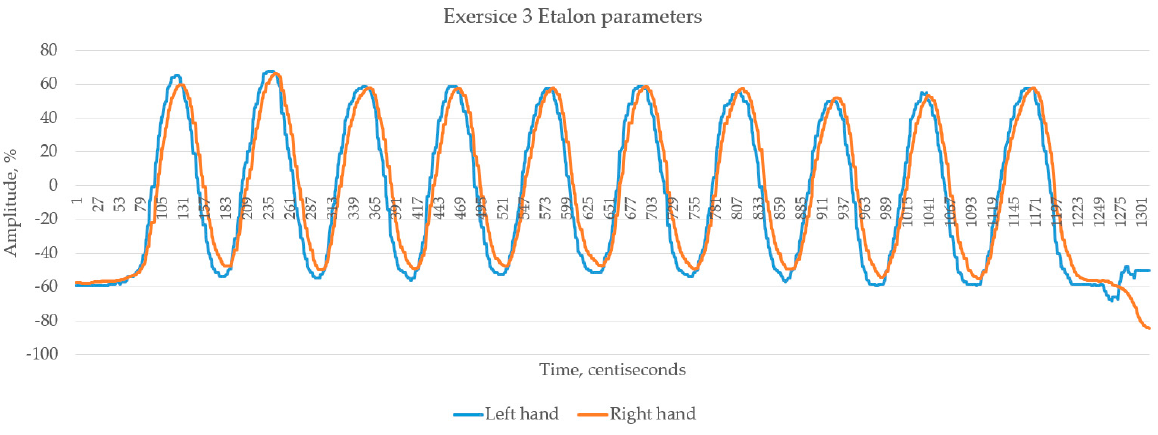
Figure 7. Etalon parameters for Exercise 3.